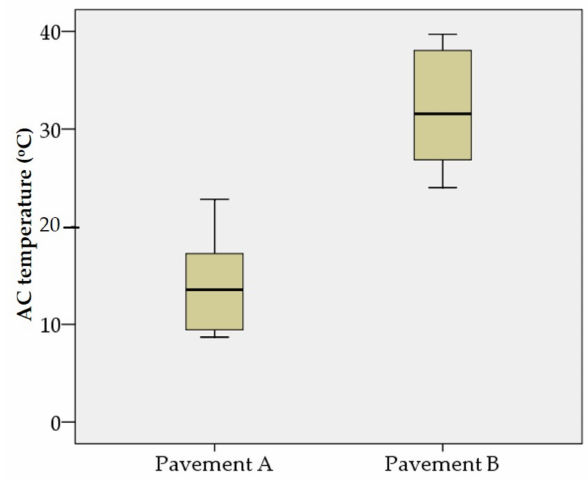
Figure 3. Range of AC temperature records during FWD measurements at both